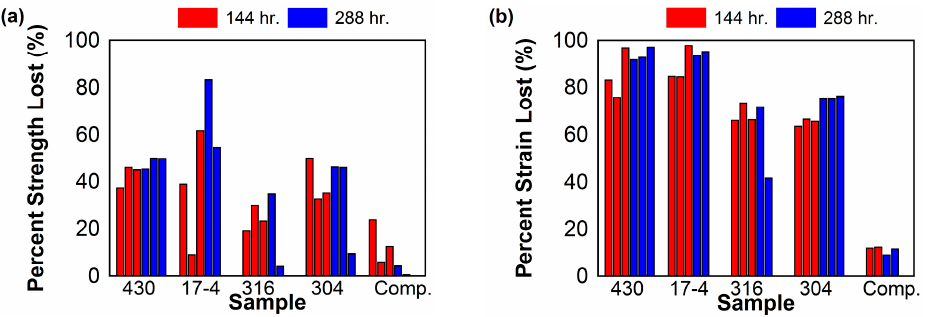
Figure 8. ( a ) Percent strength lost and ( b ) percent strain lost of each corroded sample when compared to their respective control specimens. to their respective control